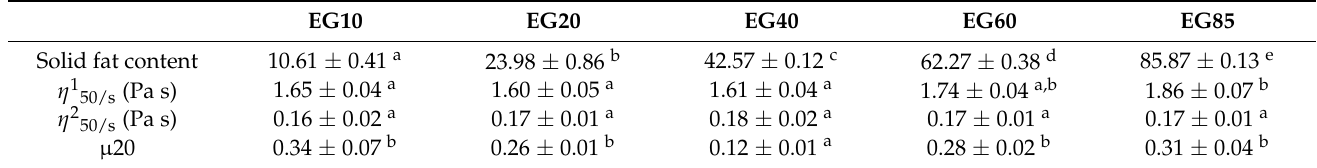
Table 3. Parameters of acid milk gels.